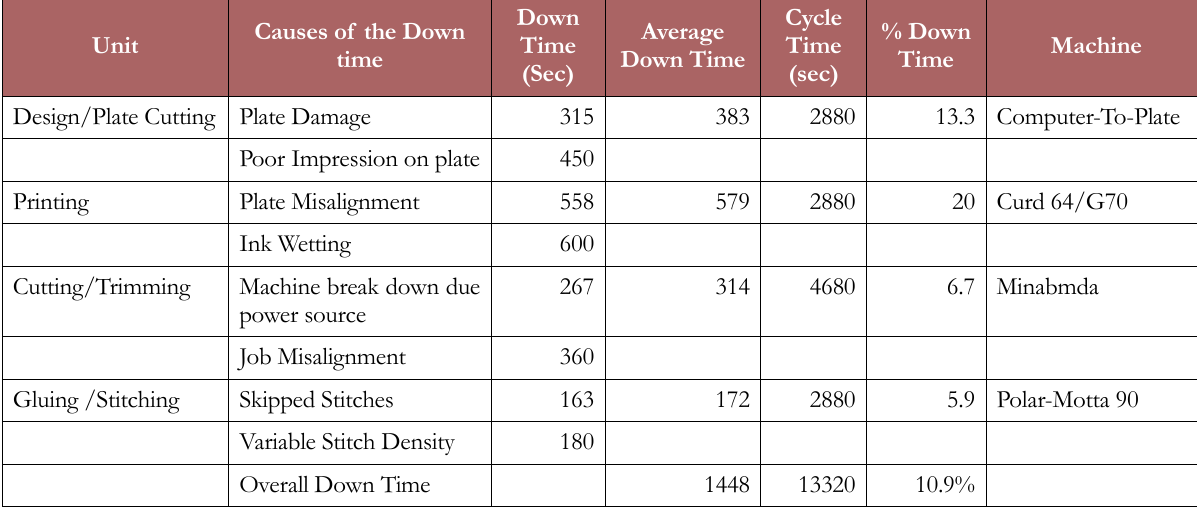
Table 10. Estimate of Improved Down Time in AB Production